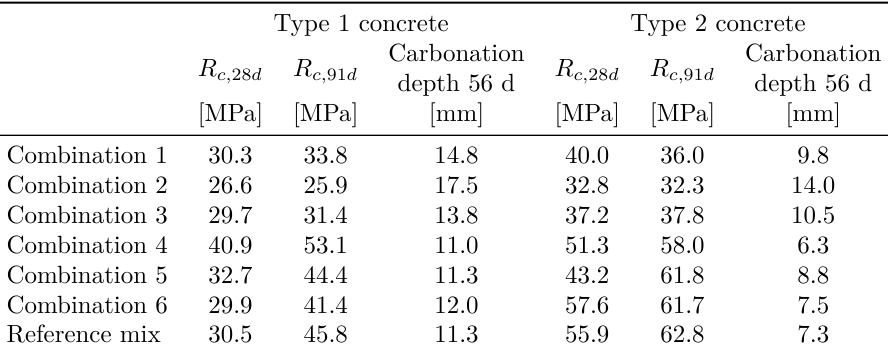
Table 5. Compressive strength and carbonation resistance of the concrete mixtures with maximum aggregate